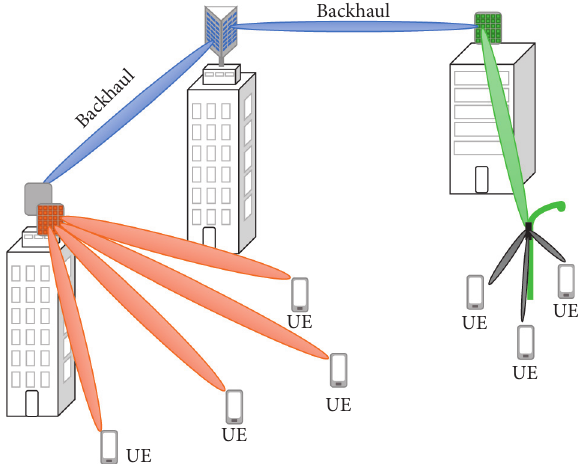
Figure 3: 5G wireless communication scenario where the use of PtP and PtM systems is shown in order to set up a communication system with user equipment